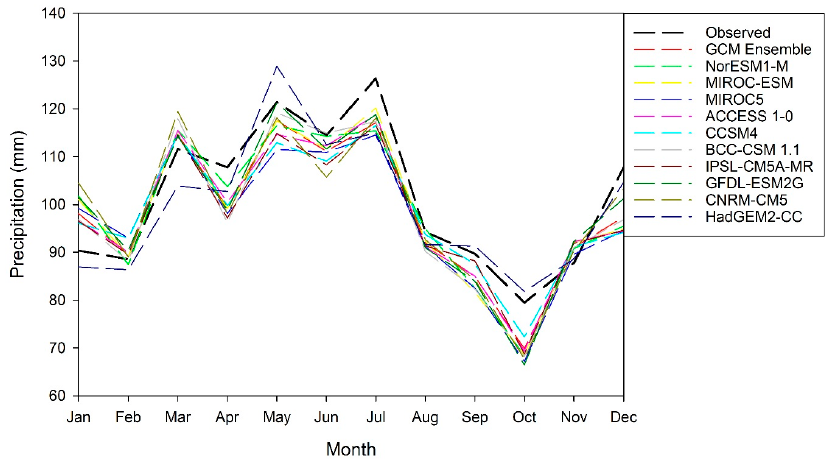
Figure 4. Observed and GCM simulated monthly precipitation in the Kentucky River Watershed (1986–2005). Table 4. Mean Absolute Error (MAE) and Normalized Standard Deviation (NSD) of GCM simulated annual precipitation in the Kentucky River Watershed (1986–2005).